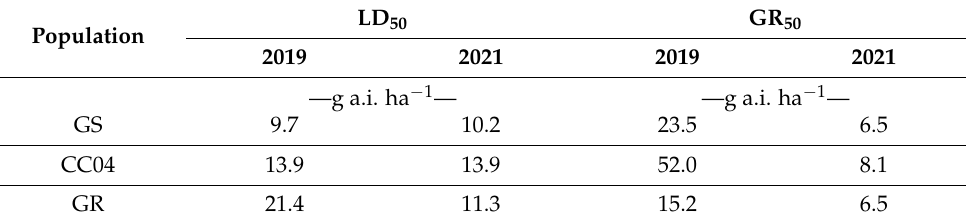
Table 7. Imazamox + Imazapyr dose required to kill 50% of plants (LD 50 ) or cause a 50% reduction in growth (GR 50 ).